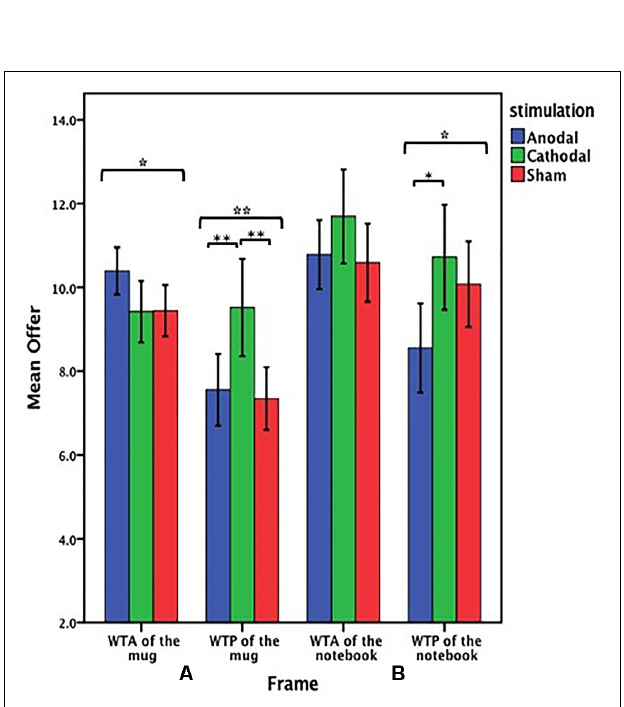
FIGURE 6 | Data of offer in the valuation task (Experiment 1). (A) The mean offer of the mug across three stimulations in each frame. (B) The mean offer of the notebook across three stimulations in each frame. Error bars indicate 95% confidence intervals. Asterisks indicate statistically significant difference between the